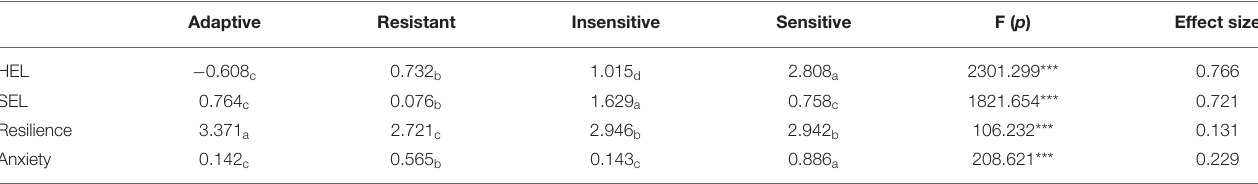
FIGURE 1 | The four perceived stress profiles and relative size of the profiles. HEL, perceived helplessness; SEL, perceived self-efficacy. Profile indicator variables were standardized values.